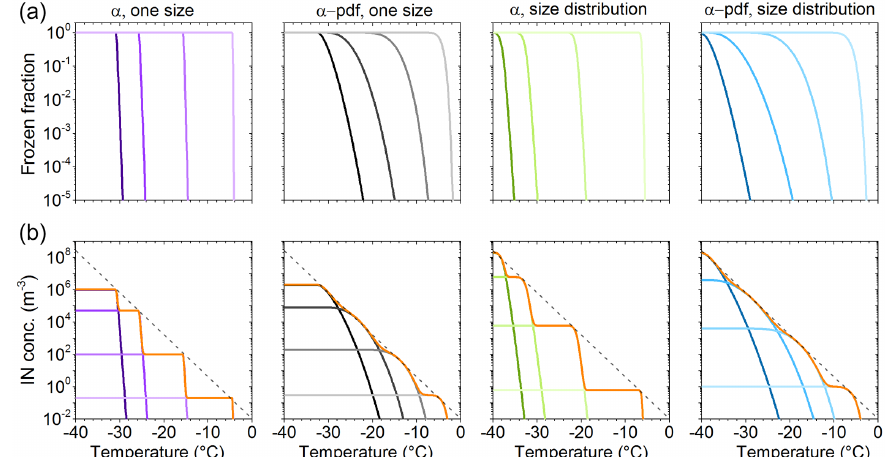
Figure A1. Illustration of the framework of the cumulative temperature spectrum. Each panel in (a) shows frozen fraction curves of four IN groups with 120, 90, 60, and 30 ◦ mean contact angles ( α ). Above the panels, variations in contact angle and particle size distribution within the IN groups are indicated. A normal distribution of contact angles (with µ = α , σ = 6 ◦ ) and a lognormal particle size distribution are used to visualize the effect of variability within the four IN groups. Panel (b) shows scaling of frozen fraction with IN concentrations per group chosen, so curves follow the exponential parametrization of Fletcher